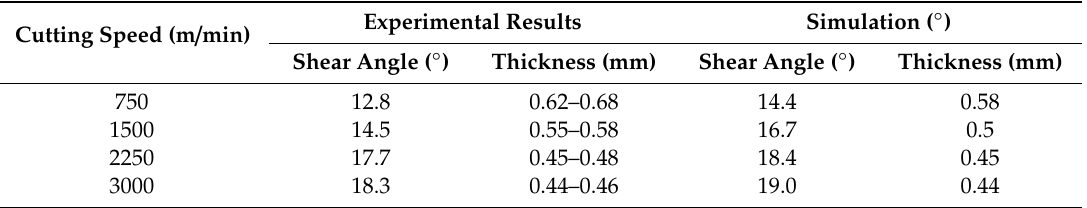
Table 5. Comparison of shear angles and chip thickness.